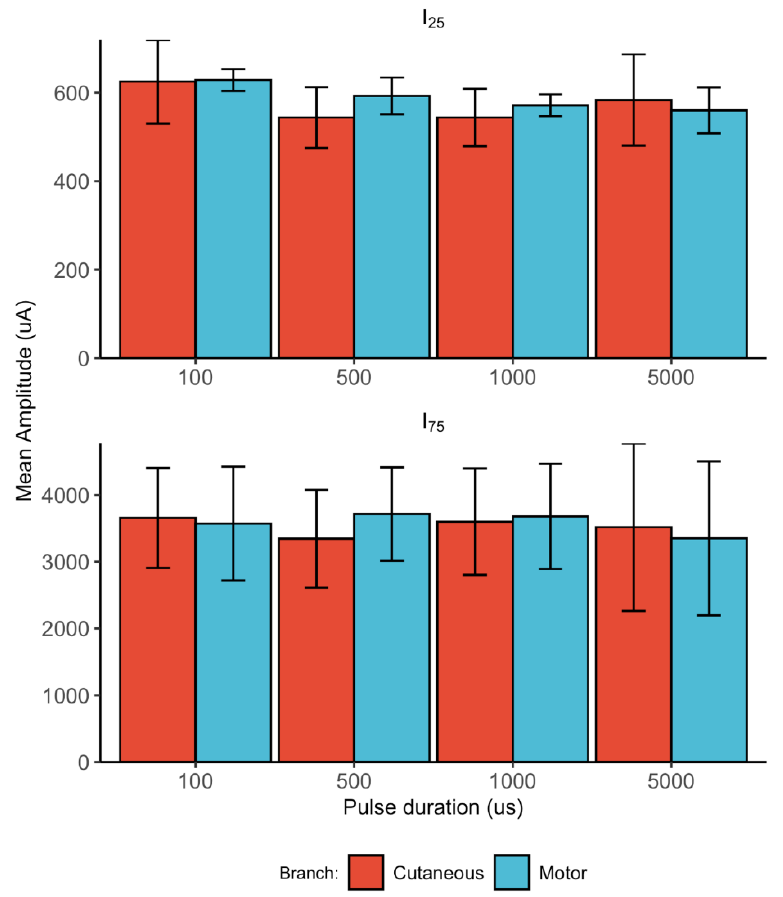
Figure 6. Mean amplitude to activate 25% (top panel, I 25 ) and 75% (bottom panel, I 75 ) of the nerve. The error bars represent the 95% confidence intervals.